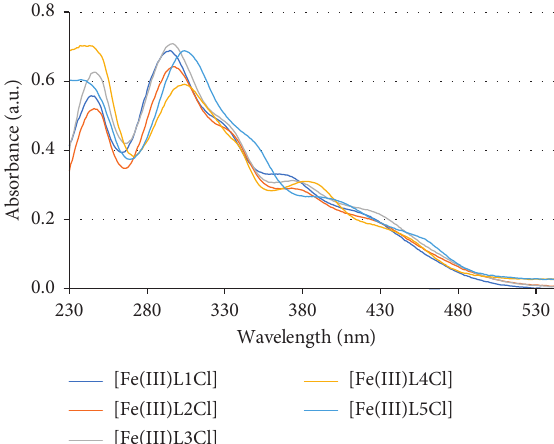
Figure 3: UV-Vis absorption spectra of unsymmetrical tetradentate Schiff base Fe(III) complexes.